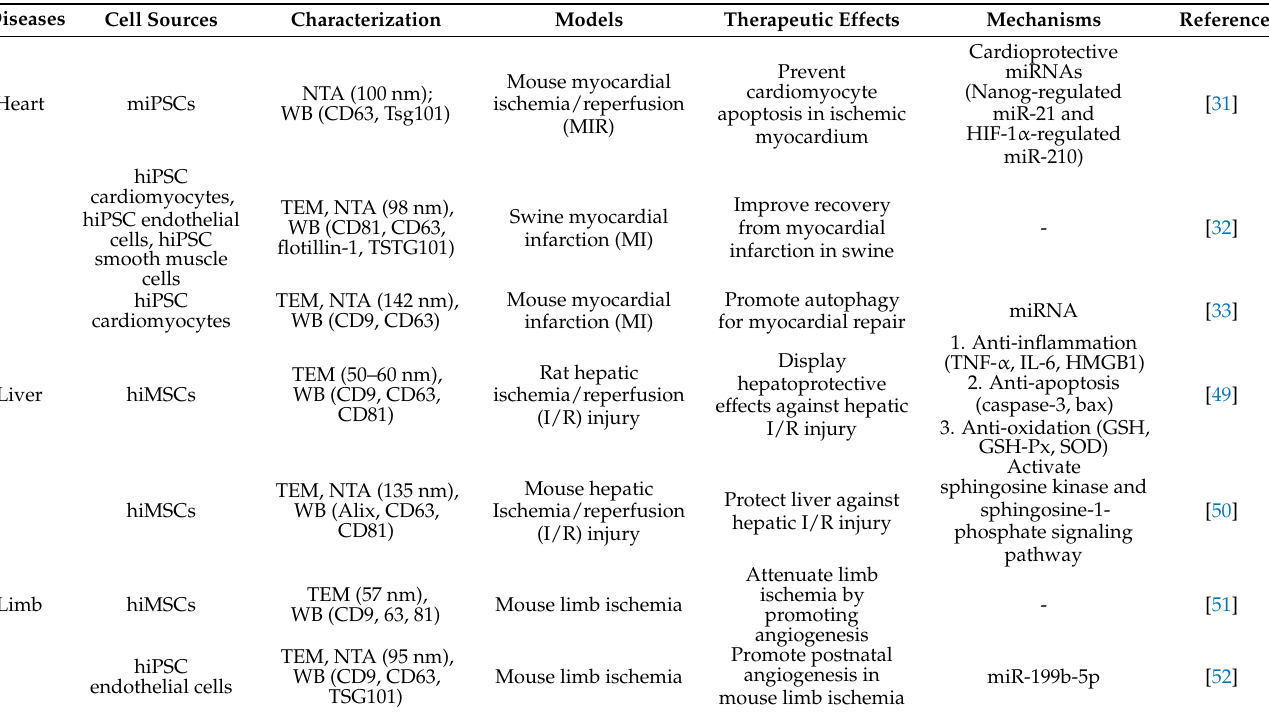
Table 1. The therapeutic applications of induced pluripotent stem cell-derived exosomes (iPSC-Exos) and iPSC-derived cell exosomes in various disease